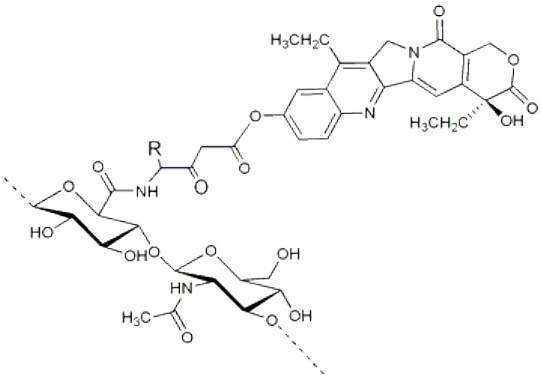
Figure 4. ONCOFID™-S, the HA-7-ethyl-10-hydroxycamptothecin (SN38) derivative obtained by conjugation of SN38-4-bromobutyrate to HA